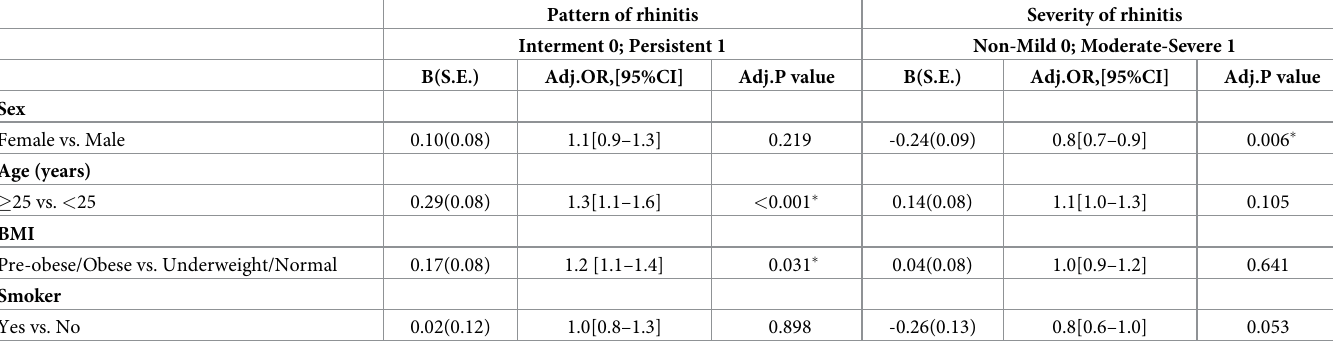
Table 5. Factors significantly associated with pattern and severity of allergic